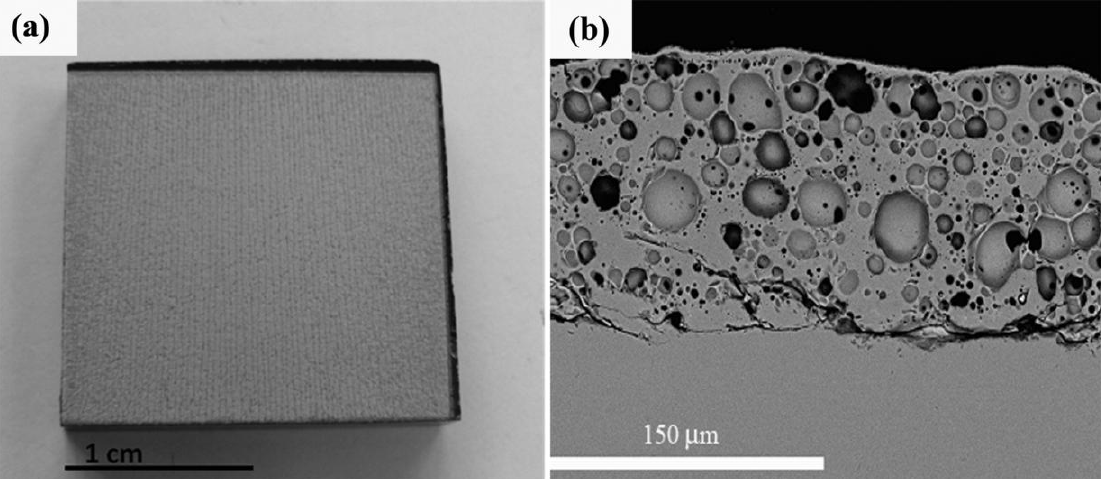
Figure 3. Top view ( a ) and cross-section micrograph ( b ) of the porous coating produced with a laser system emitting at 532